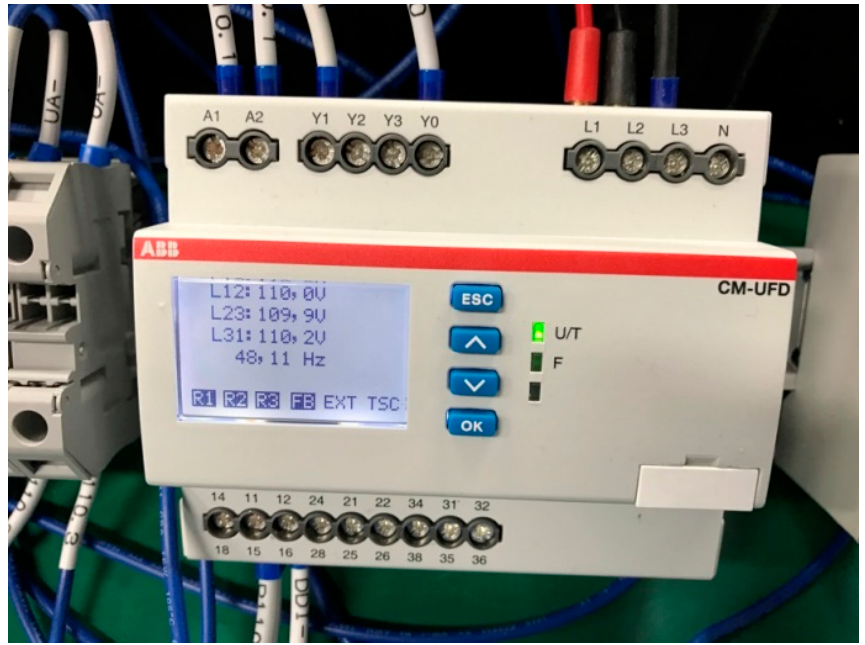
Figure 31. Resetting under frequency relay.